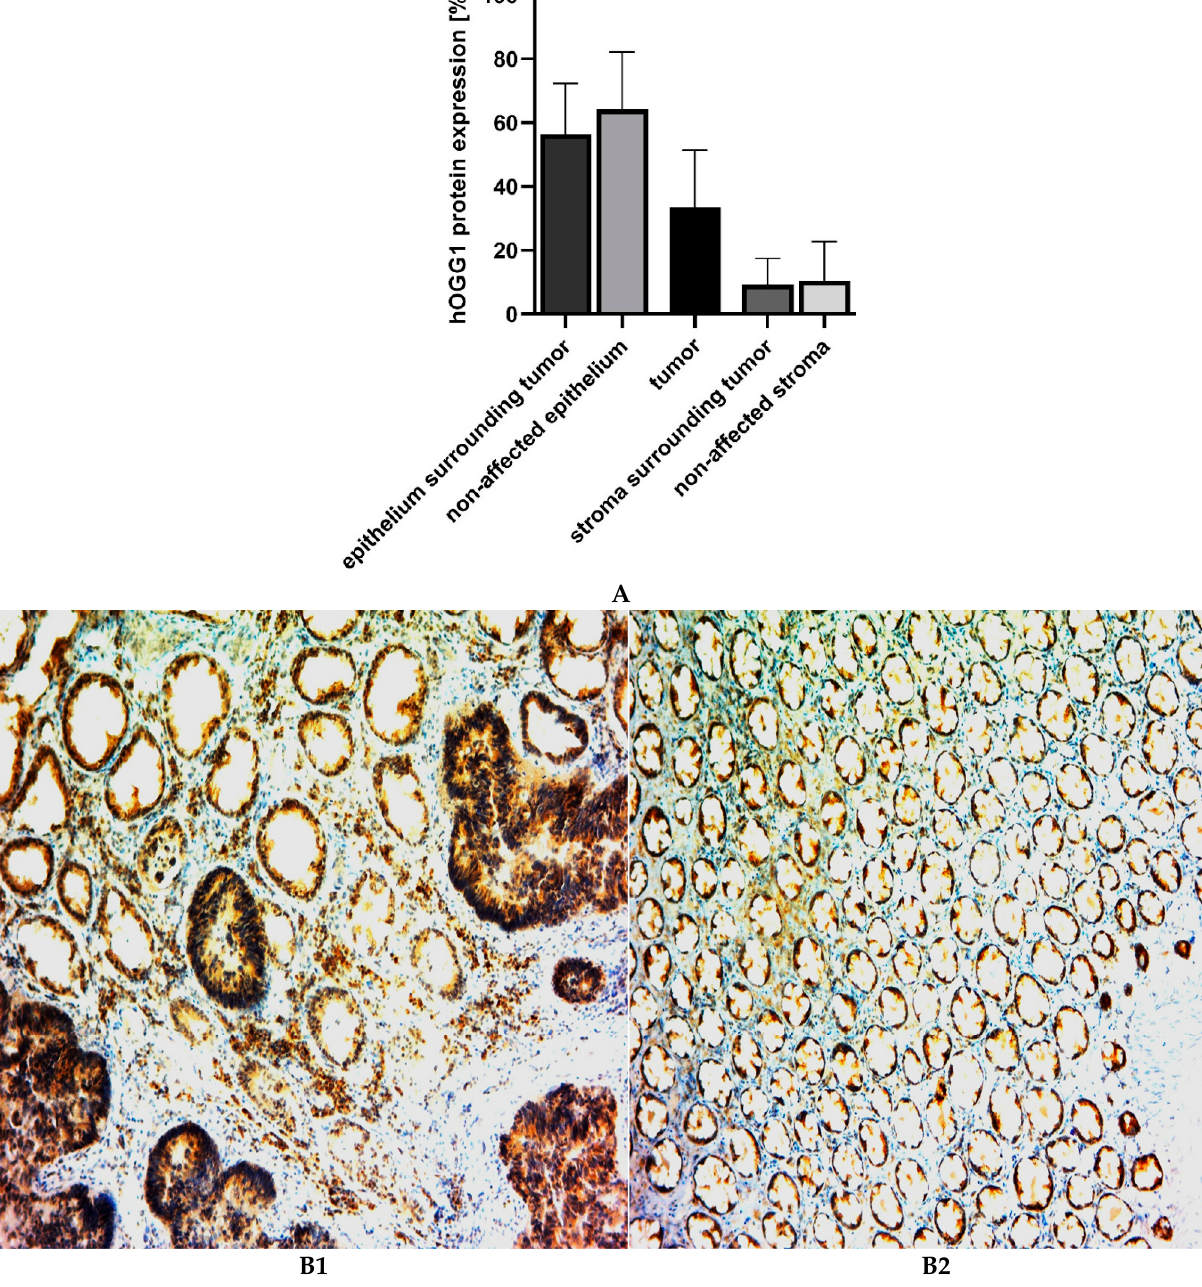
Figure 3. ( A ). hOGG1 protein expression levels in different tissues ( n = 39). ( B1 ). Representative IHC slide showing surrounding epithelial cells, adenocarcinoma cells and stromal cells. Epithelial cells exhibited highest and most consistent positivity of hOGG1, positivity in tumor is lower and the lowest is in stromal cells. ( B2 ). IHC slide showing non-affected mucosa with positive epithelial cells and less positive stromal cells.